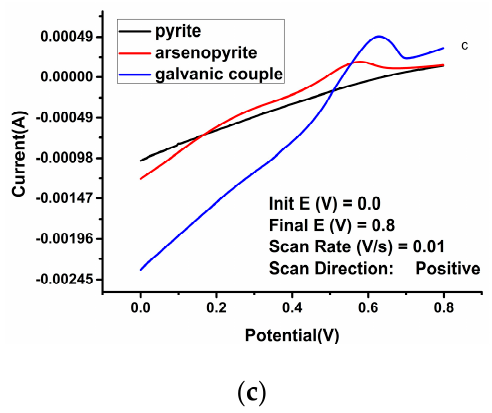
Figure 3. Linear sweep voltammetry curves of the three investigated electrodes in sulfuric acid ( a ), ferric ion ( b ), and HQ0211 strain solutions ( c ) (Init E: Initial potential of linear sweep voltammetry test, Final E: Final potential of linear sweep voltammetry